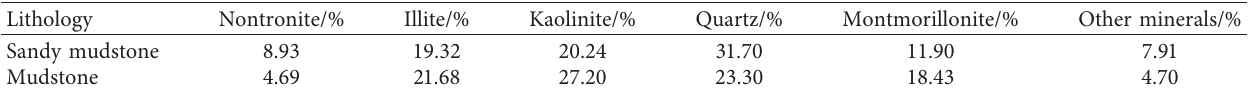
Figure 1: X-ray diffraction diagram of rock samples. (a) Sandy Mudstone and (b) mudstone. Table 1: The proportion of mineral components in